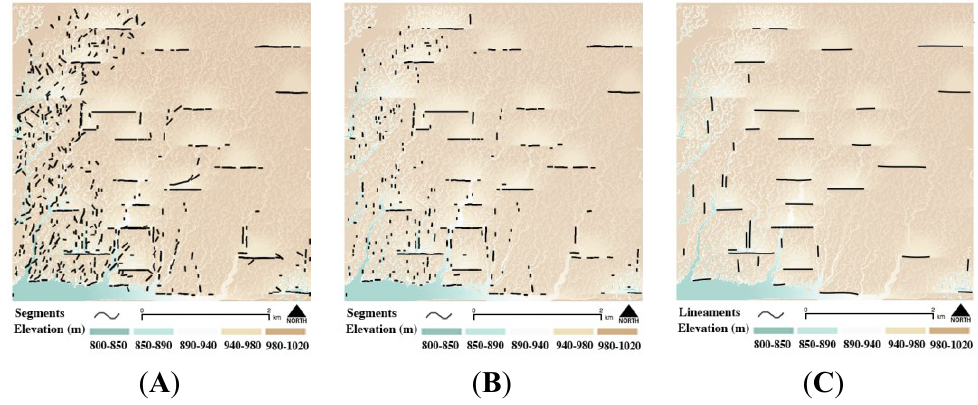
Figure 9. ( A – C ) the line segments extracted by Hough transform, Tavares-Padilha algorithm, and final resulting lineament map was obtained by B-spline method,